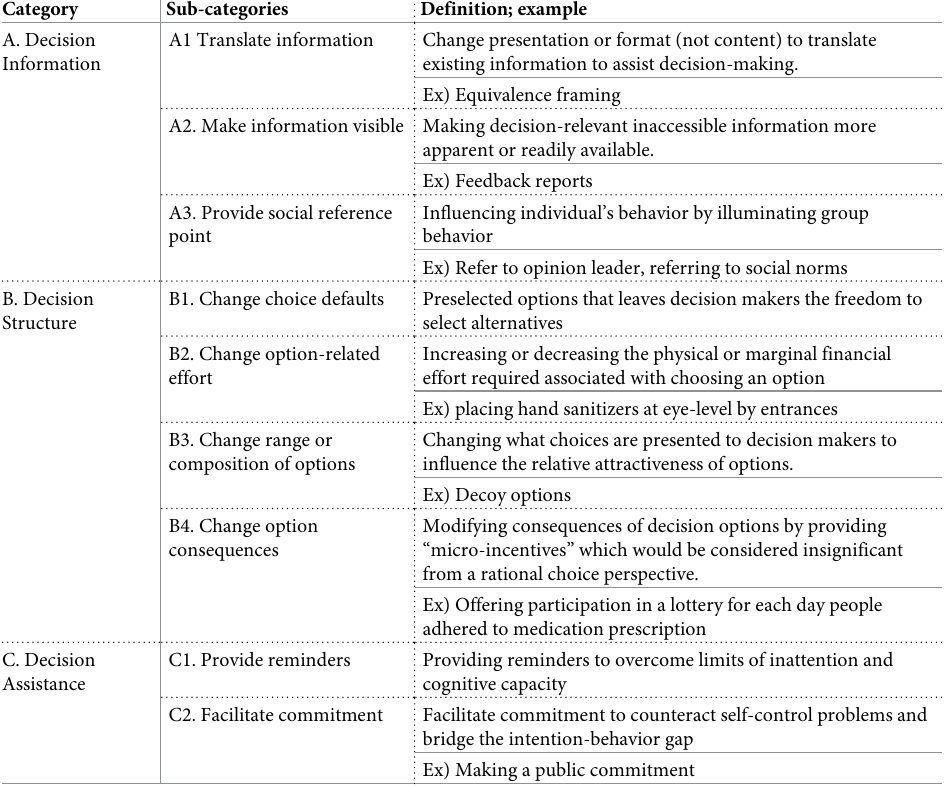
Table 2. Categorization of interventions in included studies based on taxonomy developed by Menscher et al (2016). Category